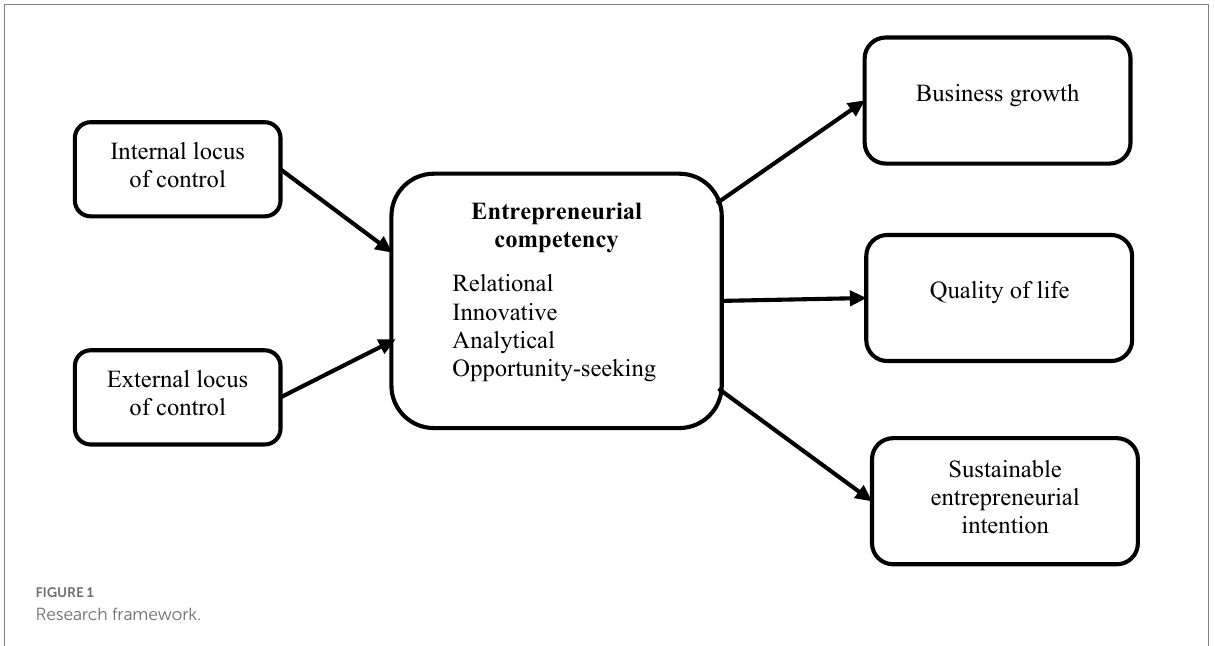
FIGURE 1 Research